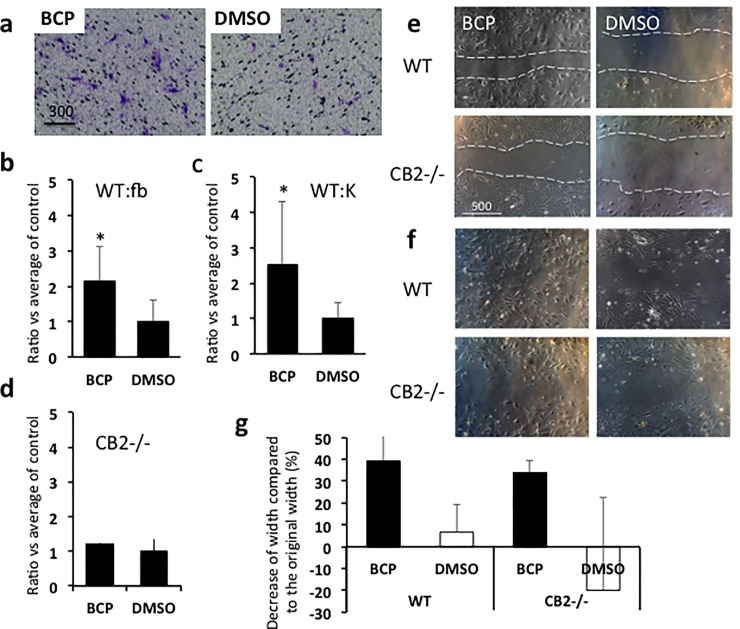
Influence of BCP on cell migration.(a) Representative results of chemotaxis assay. Cells showed chemotactic responses to BCP. Fibroblasts and keratinocytes were exposed either to BCP or to DMSO (control) in chemotaxis assay. WT cells exposed to BCP showed significantly more chemotactic responses toward the bottom of the inserts (fibroblasts, Student T-test, T = 2.564, df = 8, P = 0.033, BCP, n = 4, DMSO, n = 4, (b); keratinocytes, Student T-test, T = 2.456, df = 8, P = 0.04, BCP, n = 4, DMSO, n = 4, (c)), but cells isolated from CB2 knockout mice did not show differences between those exposed to BCP and those exposed to DMSO control (fibroblasts, Student T-test, T = 0.944, df = 4, P = 0.398, BCP, n = 3, DMSO, n = 3, (d)). (e, f, g) Results of scratch tests. Representative images on the influence of BCP (27 μM) on cell migration of fibroblasts. Six hours after scratch (e) and 1 day after scratch (f). Dotted white lines show the edge of scratched area. Scale bar = μm, (g) The distance cells migrated during the 6 hours shown as a comparison to the original width (% of shrink in width). O% means no change from original width. ANOVA, Medium type, F1,8 = 7.16, P = 0.028, cell type, F1,8 = 0.365, P = 0.562, BCP, n = 3, DMSO, n = 3.